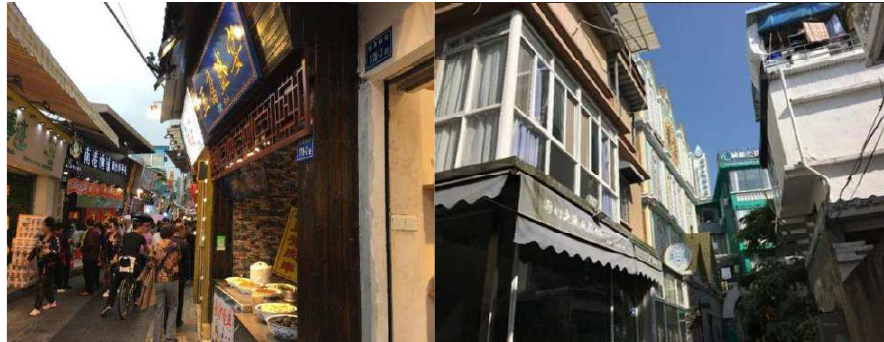
Figure 7. Creative Products Street and Commercial Street. Source: Taken by the authors.